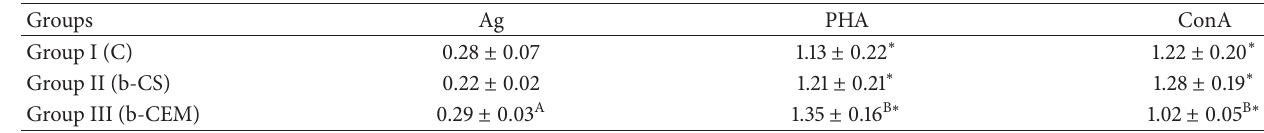
Table 4: Mean ± SE of stimulation index (SI) on stimulation with collagen sheet, native BG gallbladder antigen, PHA, and ConA in various